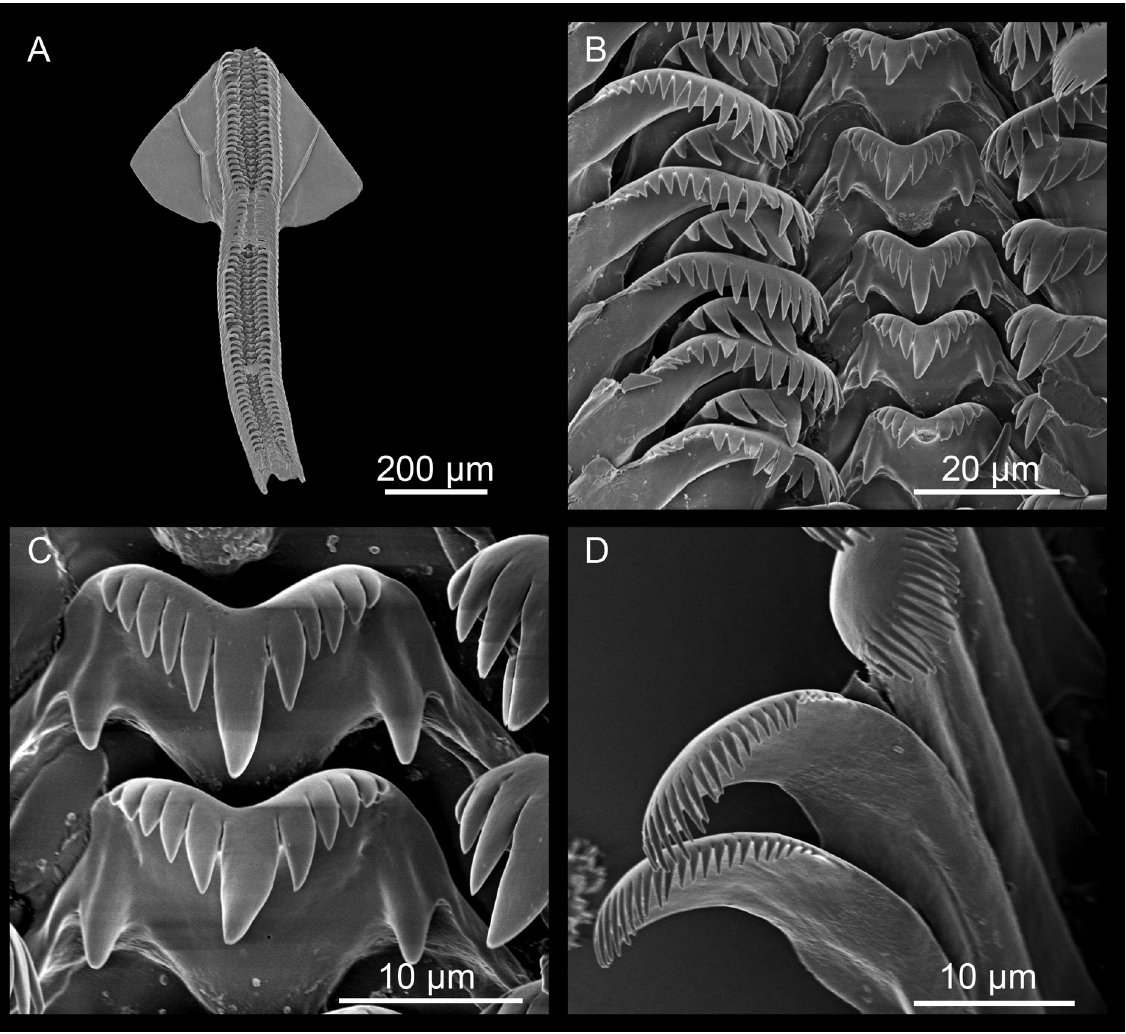
Fig. 30. Radula of the Mercuria veronicae Miller, Khalloufi & Delicado sp. nov. from El Waha Spring, Tozeur. A . General view of the radular ribbon. B . Overview of radular teeth rows. C . Detailed view of the central teeth. D . Detailed view of the outer marginal